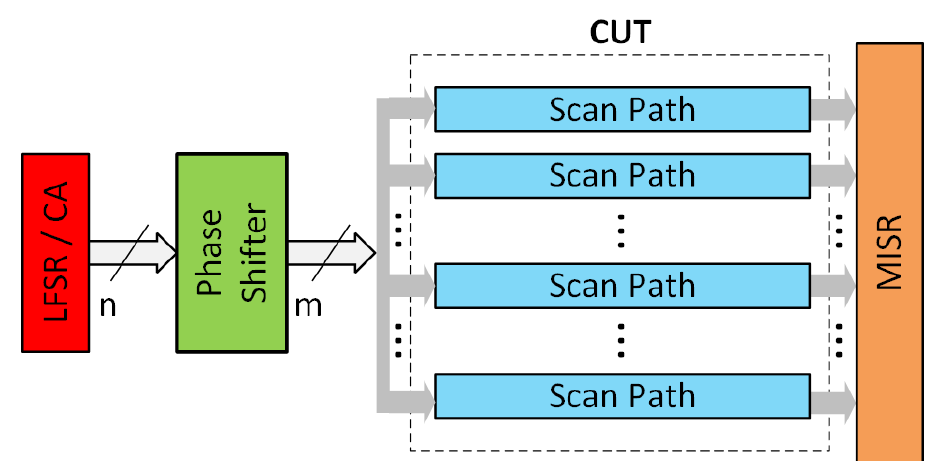
Figure 6. An LBIST module with STUMPS architecture with a pseudo-random test pattern generator composed of the LFSR or CA register and a phase shifter.